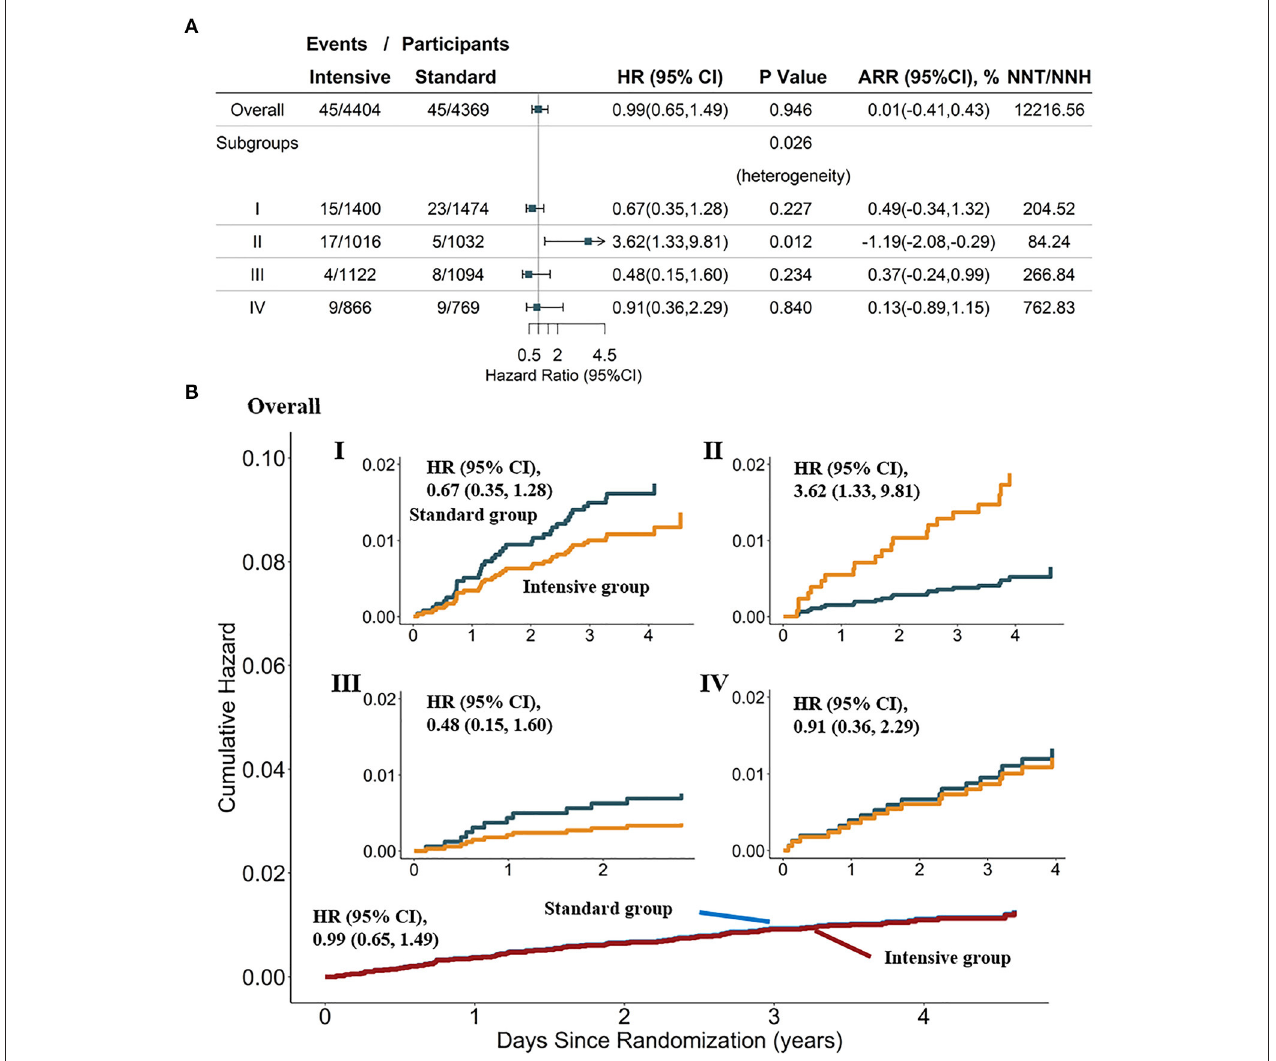
FIGURE 3 | Heterogeneity analysis and cumulative hazard curves for non-MI ACS in the overall population and four SOM-based subgroups in the SPRINT dataset ( n = 8,773). (A) Results from Cox analysis and heterogeneity analysis of four SOM-based subgroups, with adjustment for age, female sex, smoking status, BMI, statin use, and race; absolute risk reduction (ARR) = CVD incidence in the standard-treatment group—CVD incidence in the intensive-treatment group. (B) Cumulative hazard curves across intensive and standard treatment groups, adjustment for age, female, smoking status, BMI, statin use, race. SPRINT, systolic blood pressure intervention trial; SOM, self-organizing maps; non-MI ACS, non-myocardial infarction acute coronary